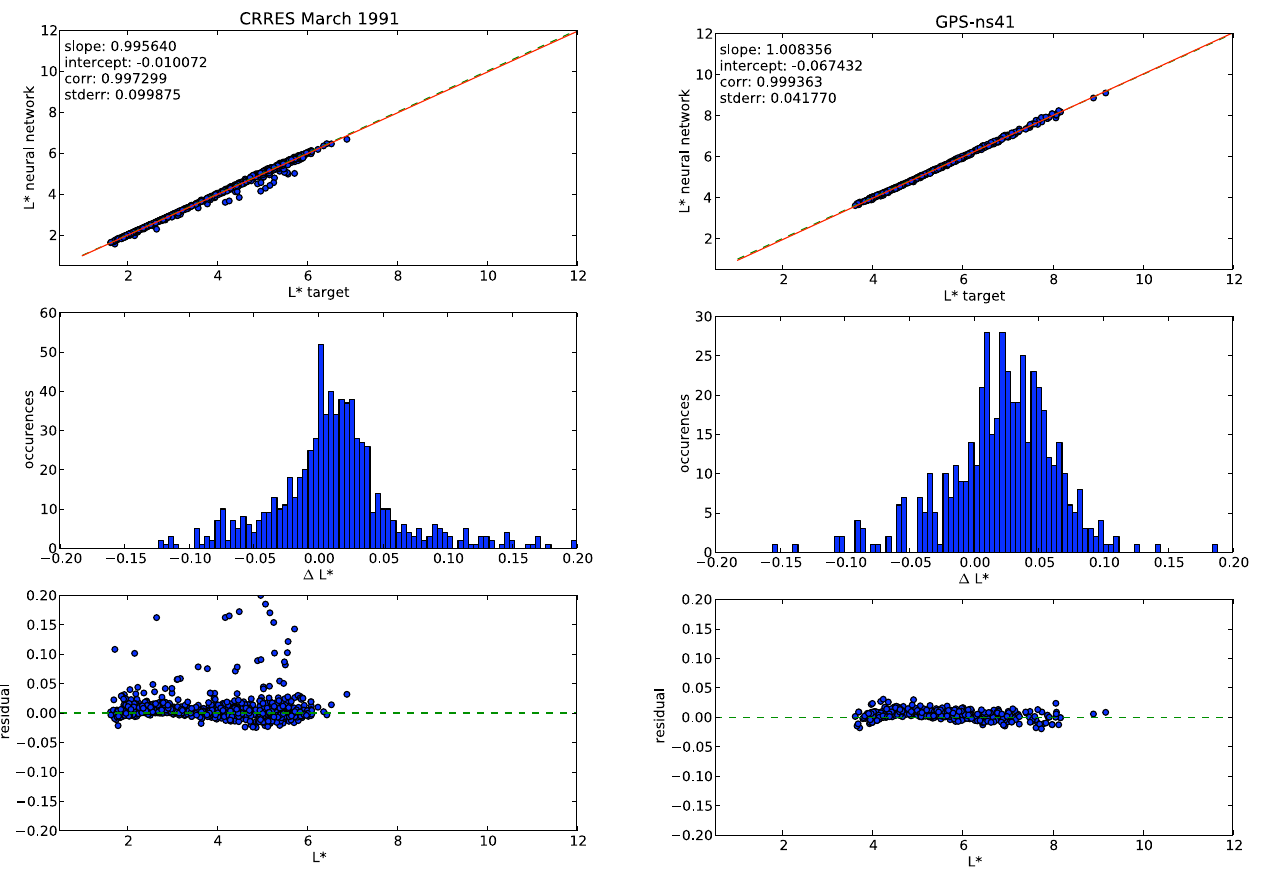
Fig. 3. Validation of neural network with GPS-ns41 satellite ephemerides. Top: scatter plot of L ∗ values from TS05 model (target) against neural network results. Green-dashed line indicates a perfect fit and red solid line indicates the least-square fit to the scatter plot. One thousand ephemeris points and solar wind con- ditions were randomly chosen between 1–30 April 2004. Middle: histogram plot of overall residuals from scatter plot. Bottom: resid- ual plot as a function of L ∗